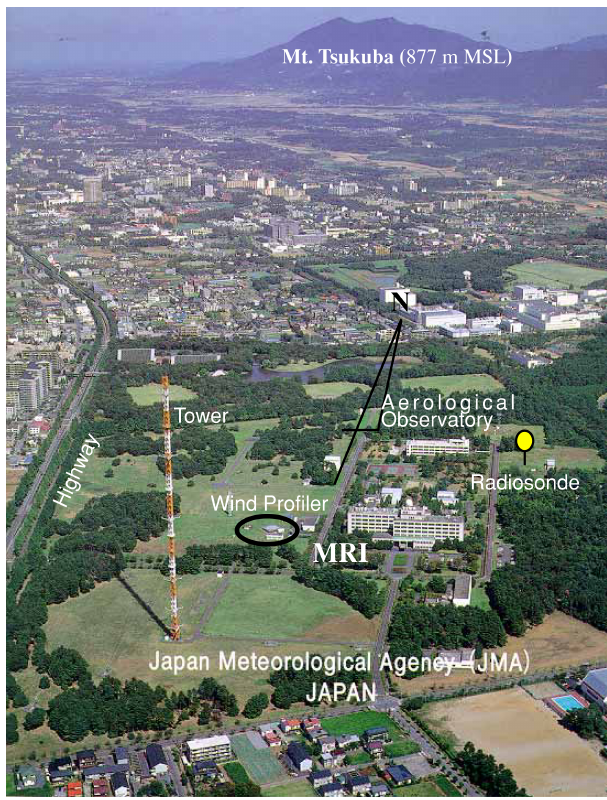
Fig. 1. Picture of the Meteorological Research Institute (MRI) and Aerological Observatory, looking north-northwest towards Mt. Tsukuba. The 213-m meteorological tower has instrument plat- forms at 10, 25, 50, 100, 150, and 200m, with additional instru- ments at the top. A portion of a nearby highway can be seen on the left edge of the